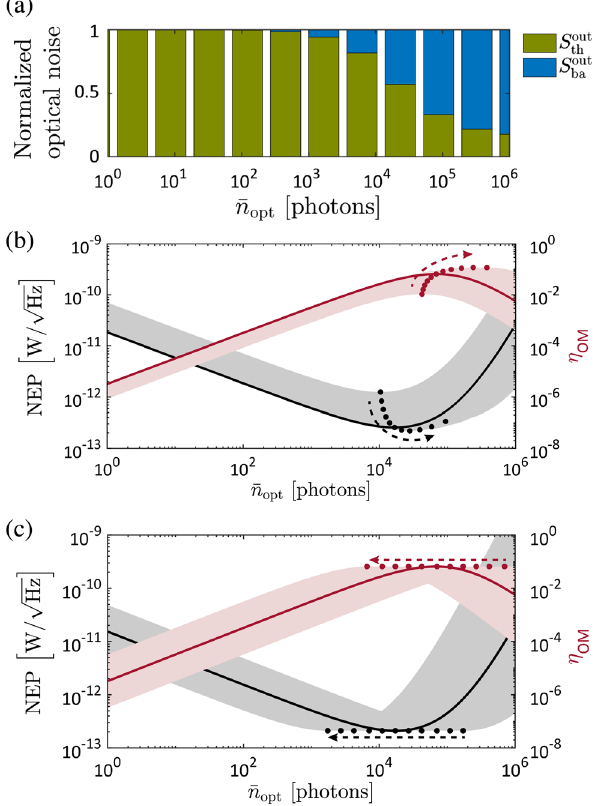
FIG. 4. (a) Relative contributions to outgoing optical noise ( S out ) on the anti-Stokes sideband as a function of the intracavity opt photon number for a pump tone red-detuned from the resonance of the optical antenna ( Δ ¼ − ω ν ). The contribution from the thermal population of the vibrational mode to the dark-count rate is depicted in green and the backaction noise in blue. (b),(c) NEP (left axis, black solid line) and power-dependent part of the internal conversion efficiency ( η , right axis, red solid line) as a OM function of the intracavity optical photon number for Δ ¼ − ω ν . The parameters used to plot the lines are described in the Appendixes. The dots indicate the extremal values in NEP and η when varying the absorption intensity ½ 0 . 1 ∶ 10 (cid:3) I IR ν in (b) or OM the Raman activity ½ 0 . 1 ∶ 10 (cid:3) R LL ν in (c). The colored areas denote the NEP and η achievable when sweeping either parameter, OM and the dashed arrows indicate the direction of evolution of the extremum when increasing the parameter value.